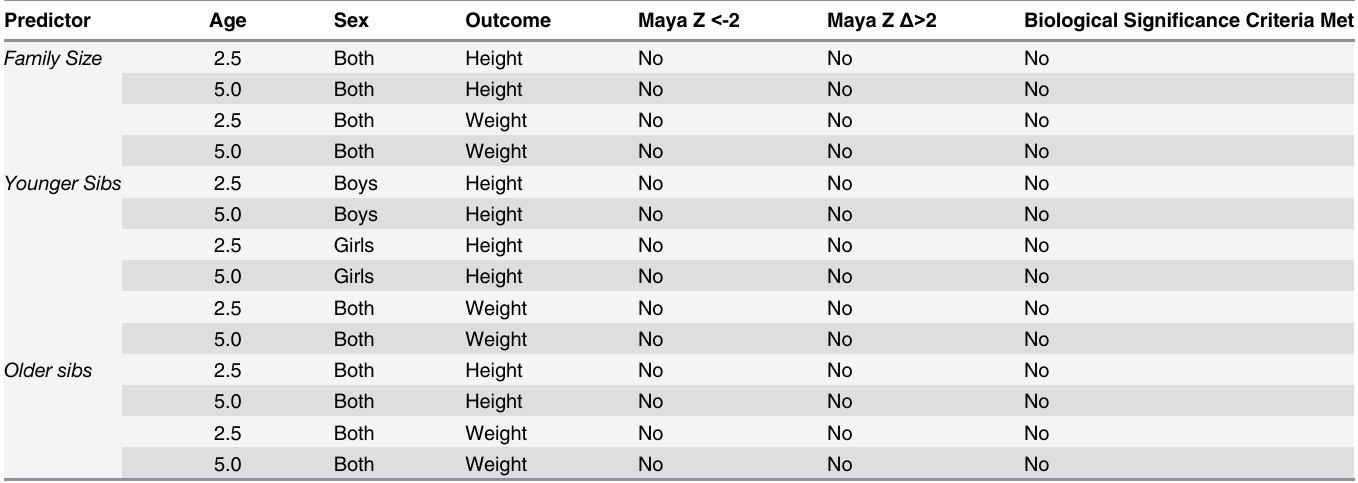
Table 3. Summary of biological significance based on two criteria: 1) Maya population-specific Z-scores < -2; 2) change in Maya population-spe- cific Z-score > 2. Relative scores are drawn from S2a and S2b Table, using the computed delta Z-score for height and weight at family sizes of 1 vs. 9, youn- ger sibling numbers of 0 vs. 3, and older sibling numbers of 1 vs. 8.